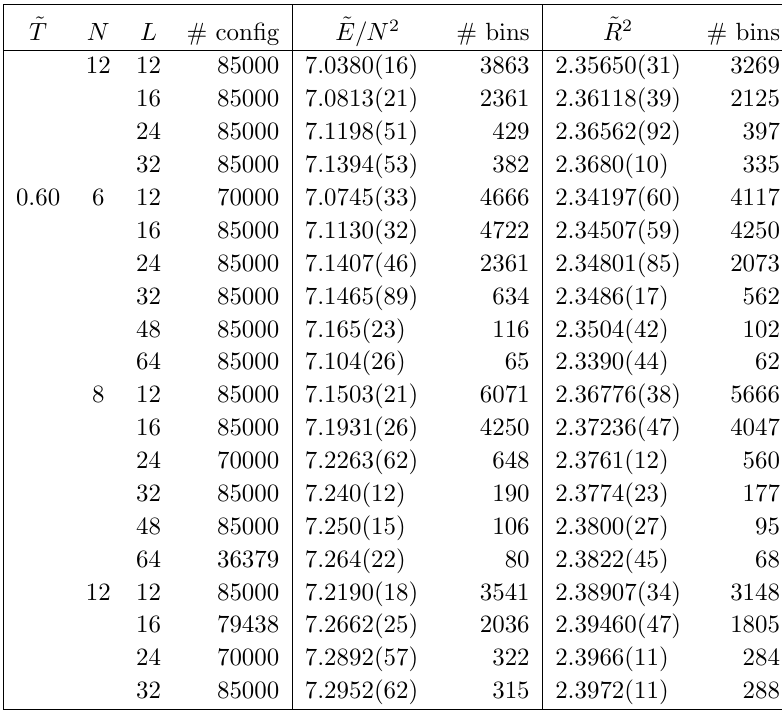
Table 7. Summary table for the parameters and expectation values of observables in the bosonic ungauged matrix